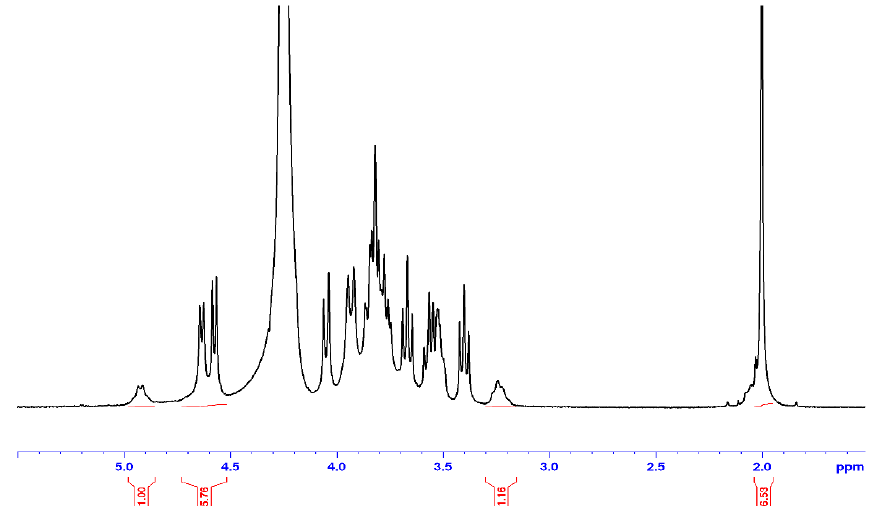
Figure 8. 1 H NMR spectrum of a complex film prepared at a charge ratio R c = 0.5 formed in W/FA (50/50 v/v ) after thermal treatment. Solvent D 2 O/DCl at 85 °C.